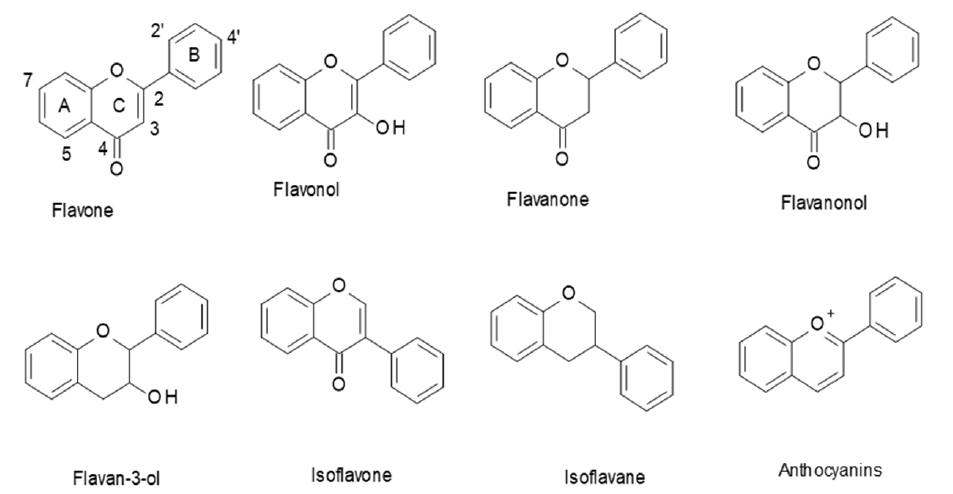
Figure 1. Structures of the main flavonoid subclasses.